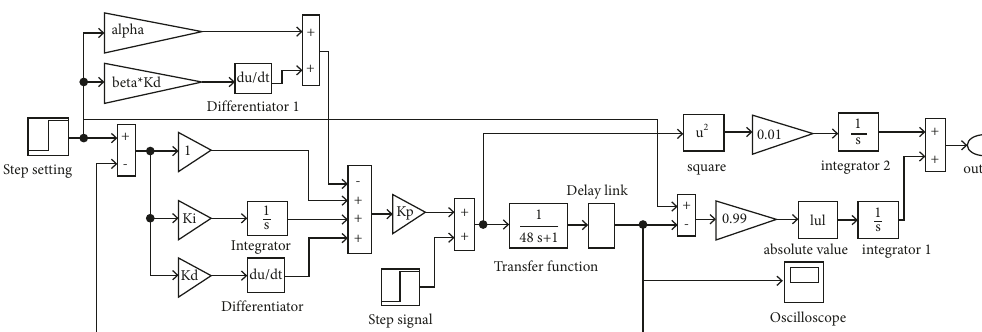
Figure 2: Simulink model of tunnel-type furnace temperature control system for genetically optimized 2-DOF PID controller.